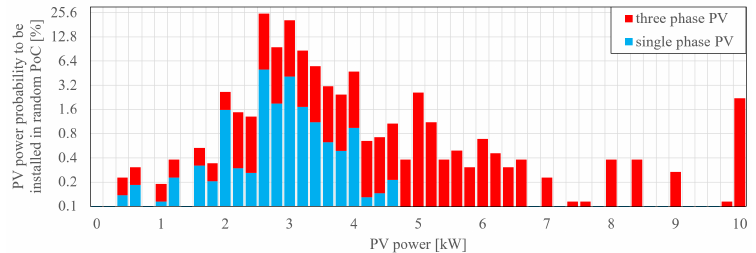
Figure 7. PV parameter